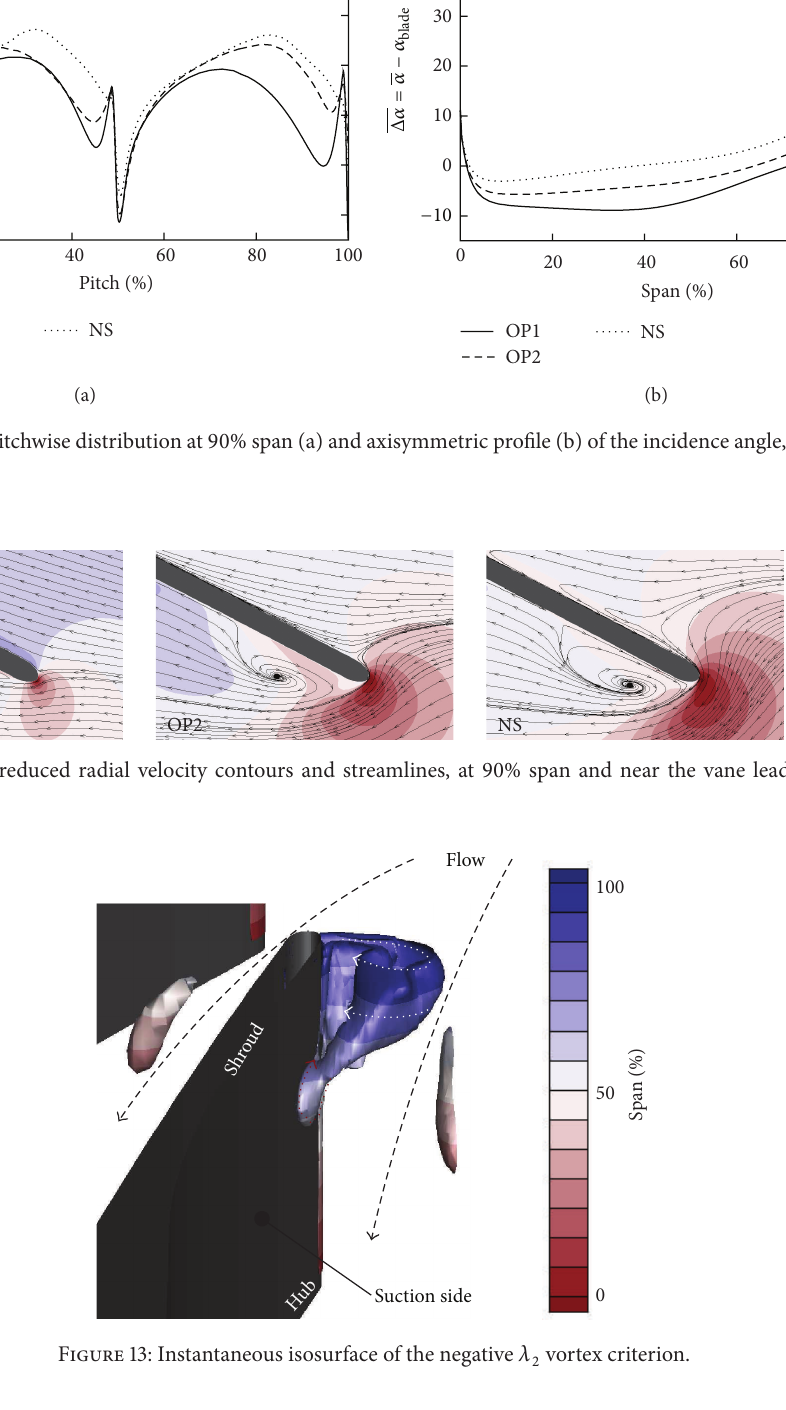
the second eigenvalue coloured by the normalized span. The separation due the high incidence angle allows the vorticity from the leading edge to be shed to form a vortex-tube. It spans from the diffuser vane suction side (60% span) to the